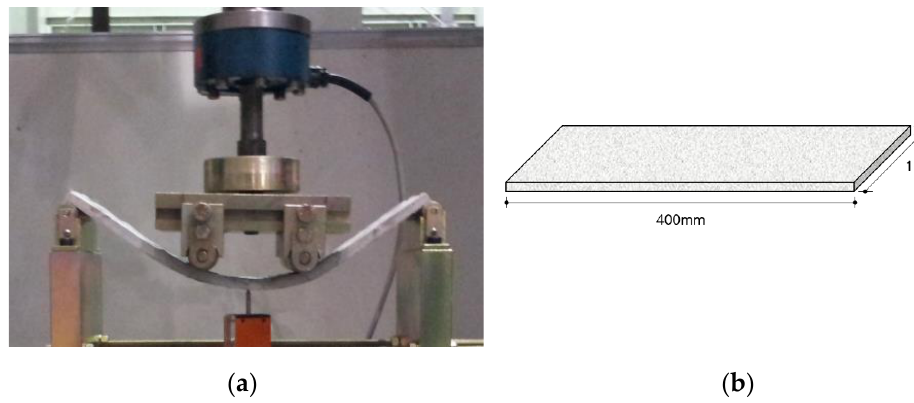
Figure 4. Bending test: ( a ) Test setup; ( b ) Specimen geometry.